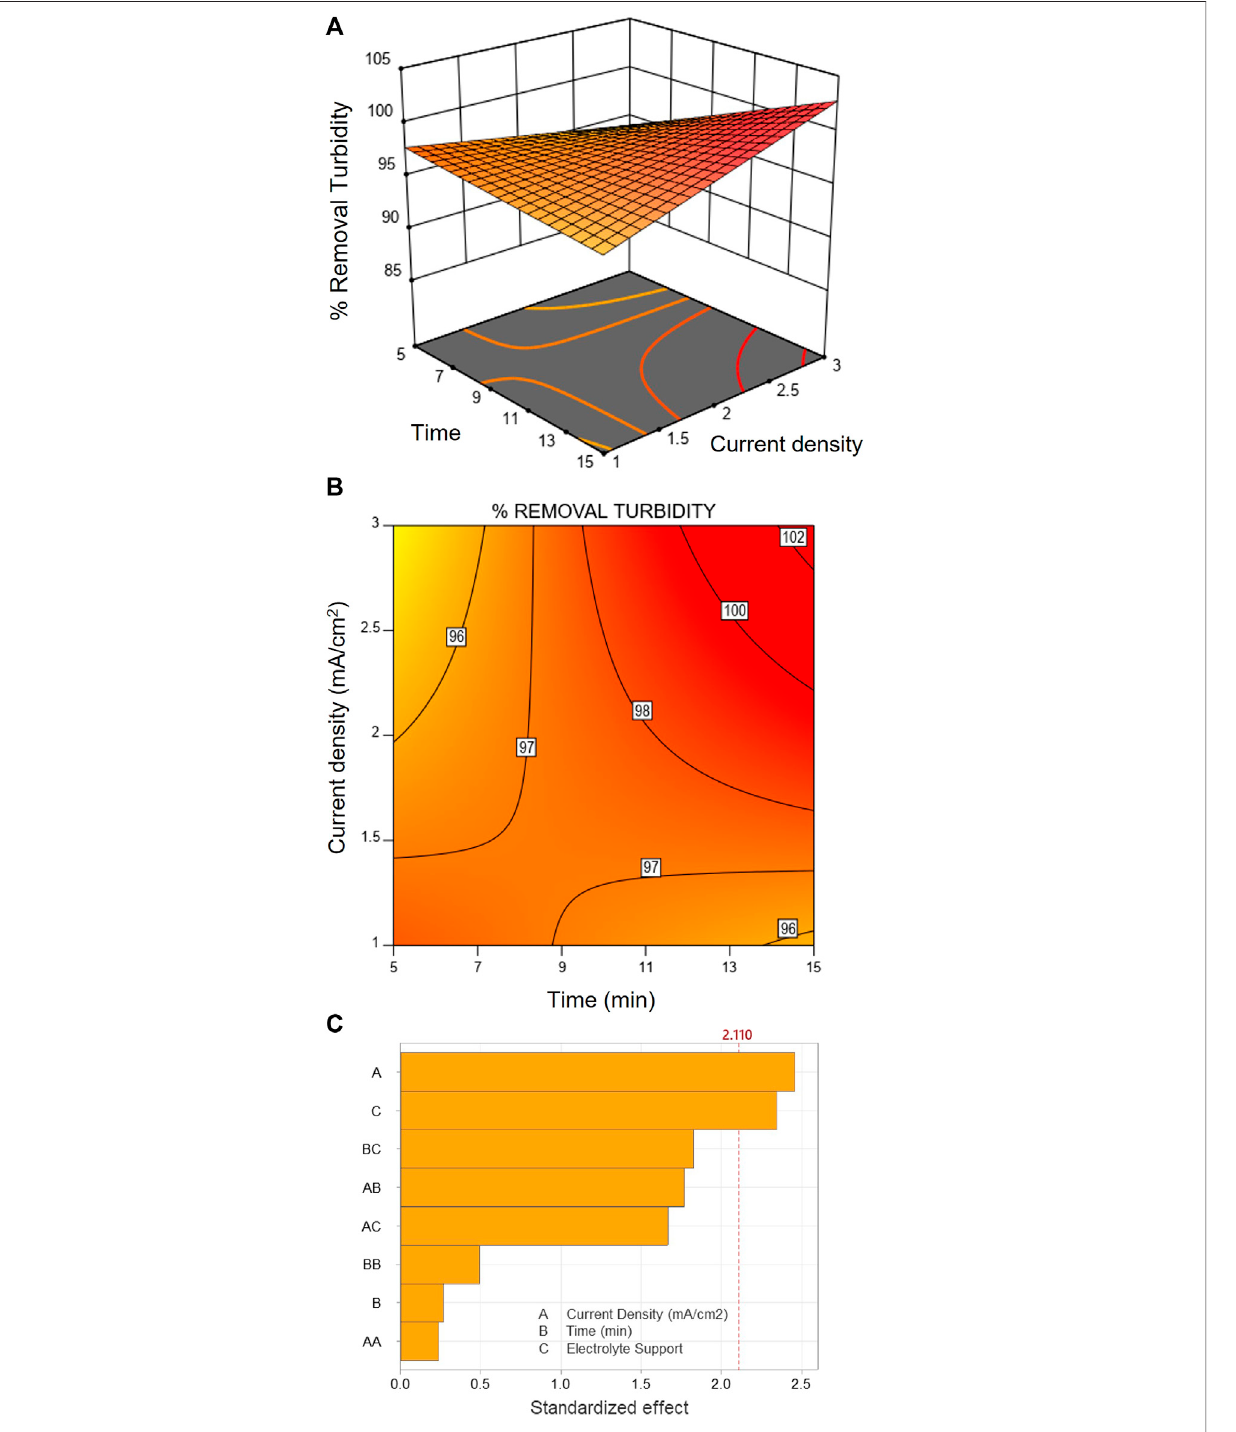
FIGURE4|(A) 3DResponseSurfaceoftheeffectofcurrentdensity(mA/cm 2 ),time(min)andelectrolytesupport(seasalt0.005M). (B) Contourplotoft(min) versus density (mA/cm 2 ). (C) Pareto plots of standardized effects, all on the turbidity removal ef fi ciency.